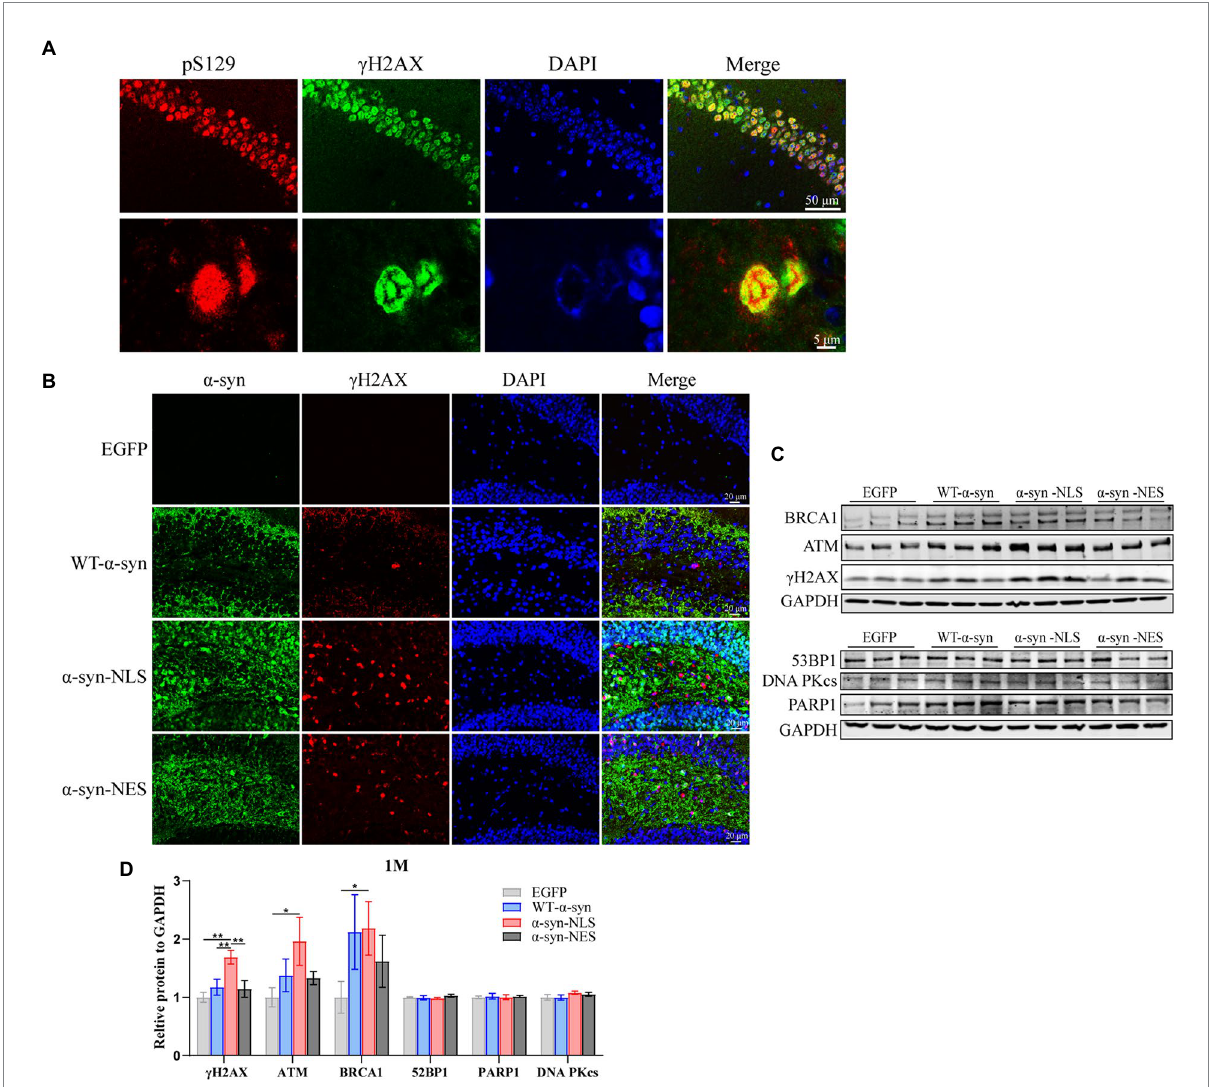
FIGURE 3 Nuclear localized α -syn induces DNA damage in mouse hippocampal neurons. (A) Confocal microscopy scans of double fluorescent staining of hippocampal tissue sections in the α -syn-NLS group at month 1 with antibodies to pS129 (red) and γ H2AX (green). (B) Immunofluorescence staining of mouse hippocampus with α -syn (green) and γ H2AX (red) antibodies after 1 month of virus injection; DAPI was used to stain all nuclei (blue). (C) Western blot of the hippocampus tissues of mice with antibodies to γ H2AX, ATM, BRCA1, 53BP1, PARP1, and DNA PKcs ( n = 3). (D) Relative levels of proteins (ratio to GAPDH) on western blot are presented ( n = 3). * p < 0.05, ** p <